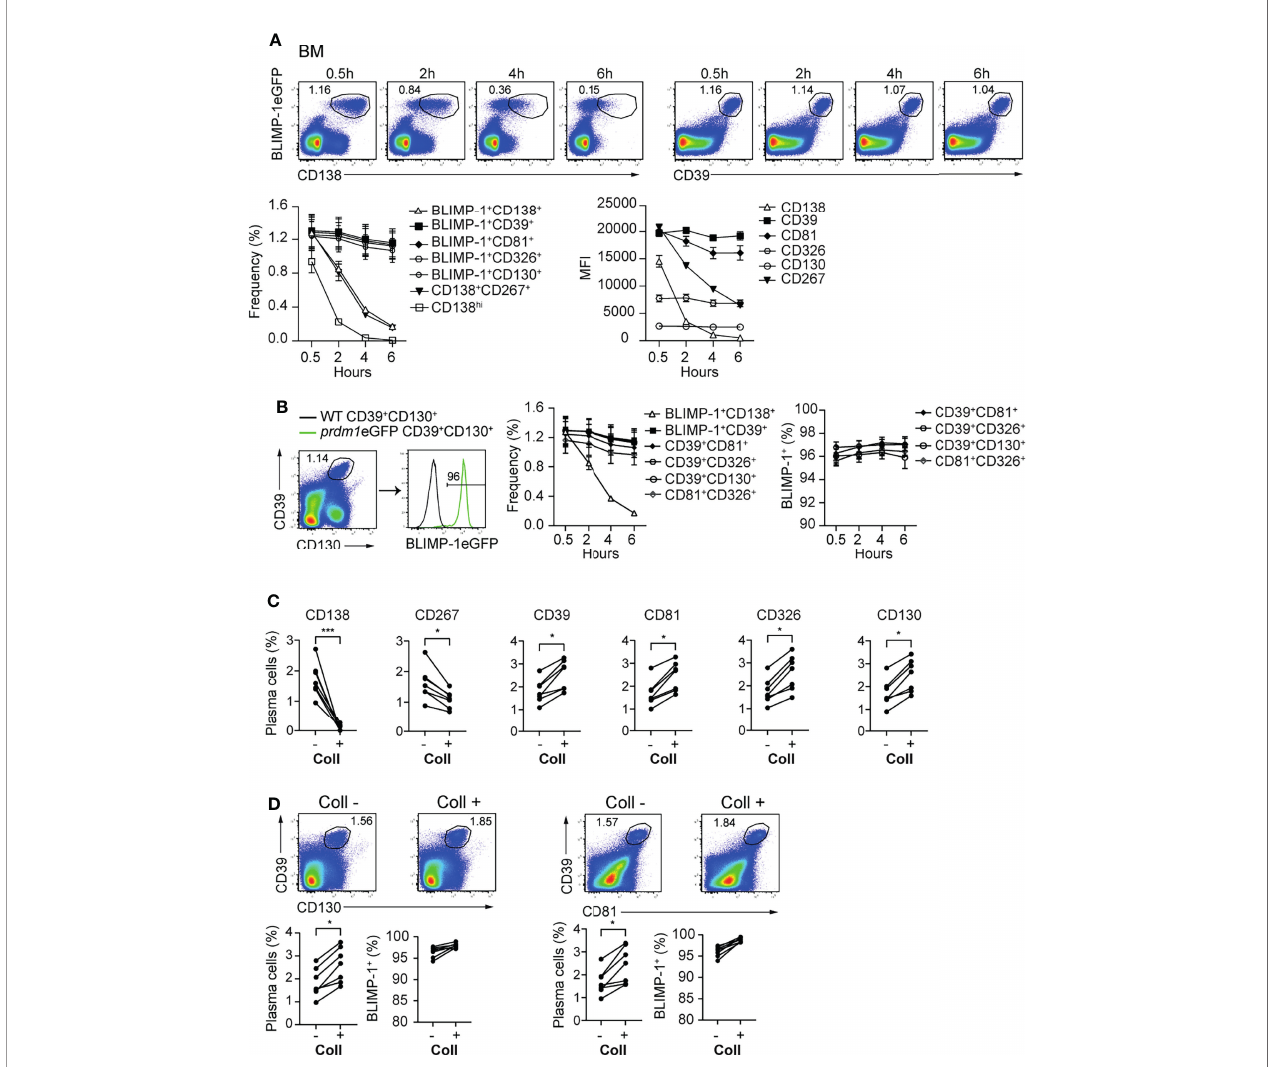
FIGURE 3 | CD39, CD81, CD130, and CD326 expression is stable and provides improved resolution for ASC identi fi cation. Analyses were performed with naive prdm1 eGFP mice, unless indicated otherwise. (A) Representative FACS plots (top) showing the co-expression of BLIMP-1eGFP with CD138 or CD39 in BM at indicated time points after BM single cell suspension preparation. The populations were gated on CD3 - live cells. Results are representative of two independent experiments (n=7 mice). The graphs show the frequency of detected ASC (left) (gated according to top FACS plots and Supplementary Figure 3B ) and MFI of indicated marker (right) in BLIMP-1eGFP + CD39 + ASCs (gated according to top right FACS plots). (B) Representative FACS plot demonstrating that ASCs gated based on the dual expression of CD39 and CD130 (left) are BLIMP-1eGFP + (right). The graphs show the frequency of ASCs identi fi ed as BLIMP-1eGFP + CD138 + , BLIMP-1eGFP + CD39 + (shown in A), CD39 + CD130 + (shown in B), CD39 + CD81 + , CD39 + CD326 + and CD81 + CD326 + ( Supplementary Figure 3C ) (left), and the frequency of BLIMP-1eGFP + expressing cells within the indicated ASC populations (right), during the time course after isolation. (C) Frequency of ASCs expressing BLIMP-1eGFP and given markers as shown in the Supplementary Figure 3D from spleen before and after collagenase (Coll) treatment. Populations were gated on CD3 - live cells. (D) Representative FACS plots (top) and frequencies (left bottom) demonstrating that ASCs can be identi fi ed as CD39 + CD130 + and CD39 + CD81 + ASCs before and after Coll treatment. Frequencies of BLIMP-1eGFP + cells within these gates (right bottom). Groups were compared using paired t test (C, D) . Data show compilation of 2 independent experiments (n=7 mice). Data show mean ± SEM (*p < 0.05, ***p <